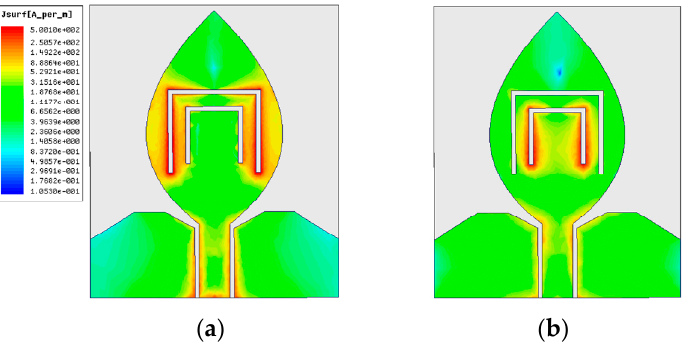
Figure 2. Simulated current distribution on the proposed antenna surface: ( a ) 3.5 GHz; ( b ) 5.5 GHz.